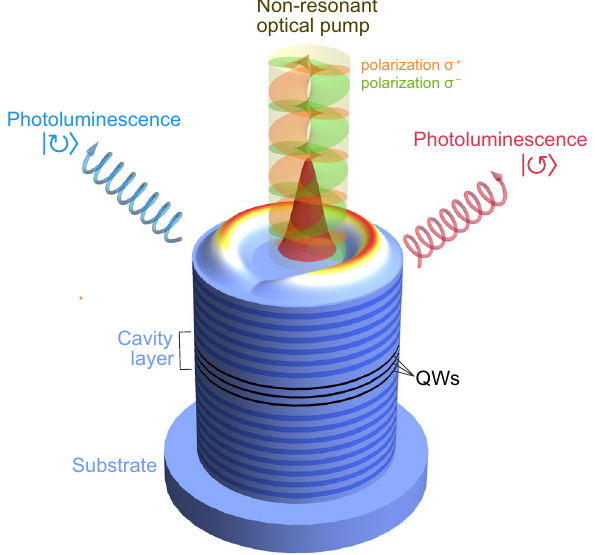
Figure 1. Schematic of the excitation of a spinor polariton current state in a cylindrical micropillar. Polaritons are excited by the polarized non-resonant cw optical pump slightly shifted from the center of the micropillar. Clockwise ( | (cid:31) � ) and anti-clockwise ( | (cid:31) � ) polariton currents characterized by nonzero OAM can emerge in different polarizations. The orbital angular momentum is transferred to the photoluminescence of the